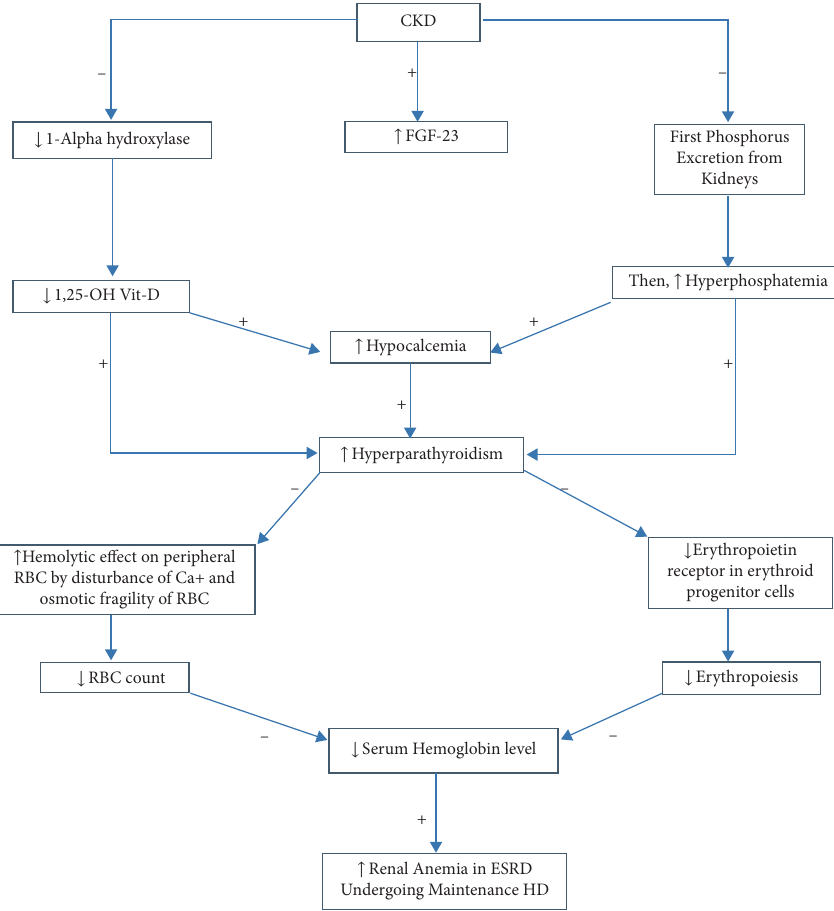
Figure 1: Schematic of the pathogenesis of renal anemia with hyperparathyroidism [8, 9]. CKD: chronic kidney disease; FGF-23: fbroblast growth factor 23; OH: hydroxy; vit-D: vitamin D; RBC: red blood cell; Ca+: calcium; ESRD: end-stage renal disease; HD: